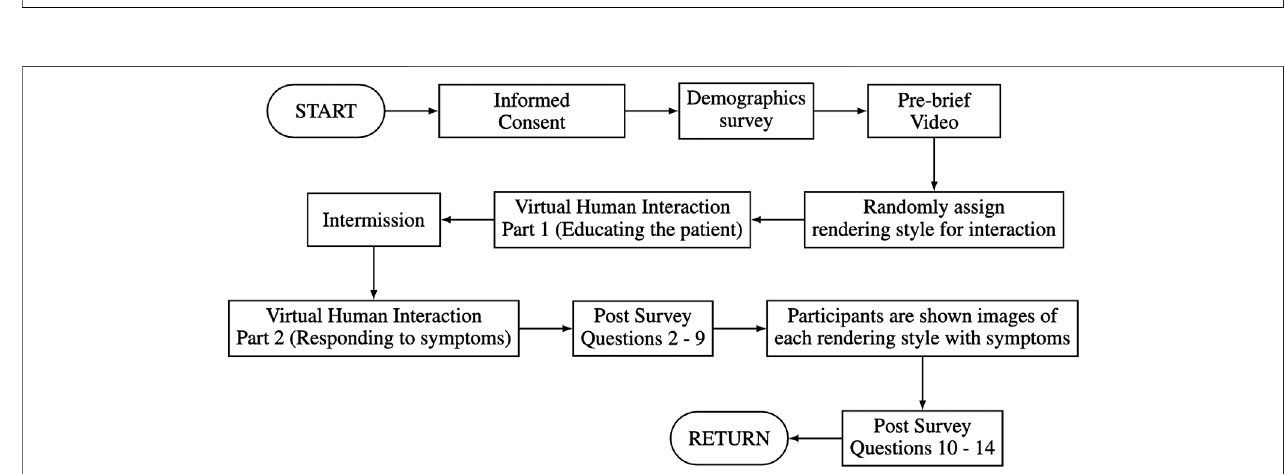
FIGURE 3 | The allergic reaction symptoms applied to the different virtual human rendering styles.